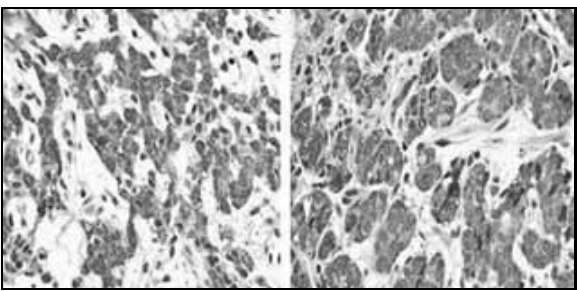
Figure 2 – Microscopic view of well differenciated gastric neuroendocrine tumor: immunohistochemical staining showing numerous ghrelin (a) and pre-proghrelin (b) immunoreactive cells. a and b 400 ×